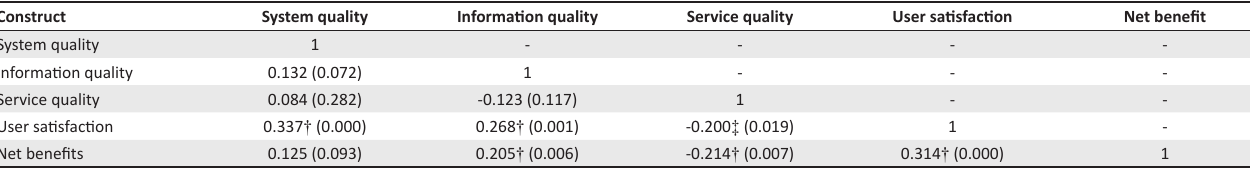
TABLE 2: Correlation matrix. Construct